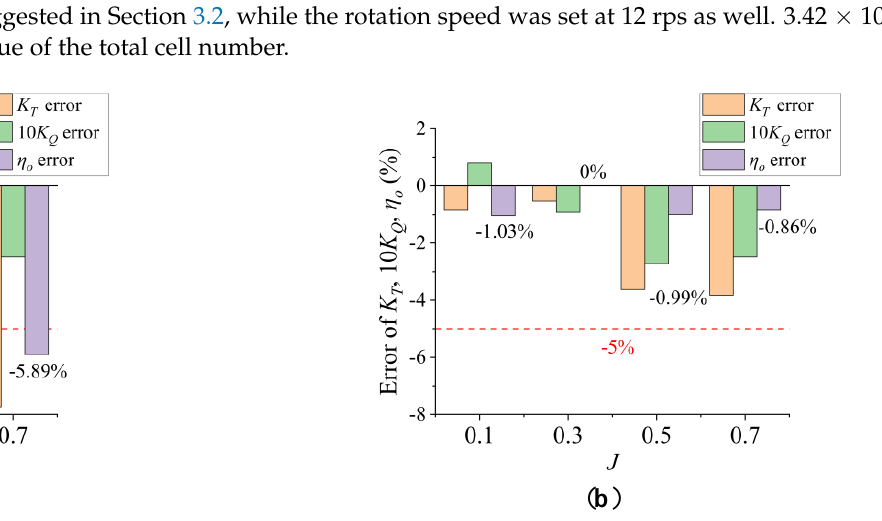
Figure 6. Open-water performance calculation error of propeller P1727 on model scale in cavitating flow without counting γ transition ( a ) and considering γ transition ( b ) (error = (CFD-EFD)/EFD × 100%. The error of the η o has been labeled in the figure).